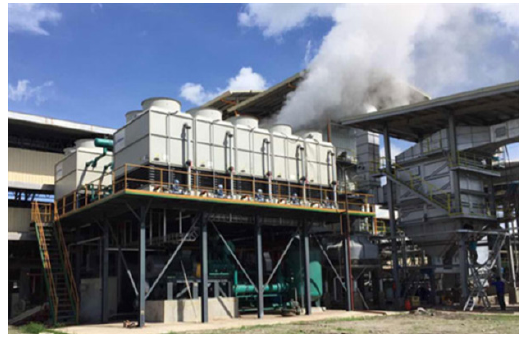
Figure 12. The screw generator set in Yangyi Tibet, China.